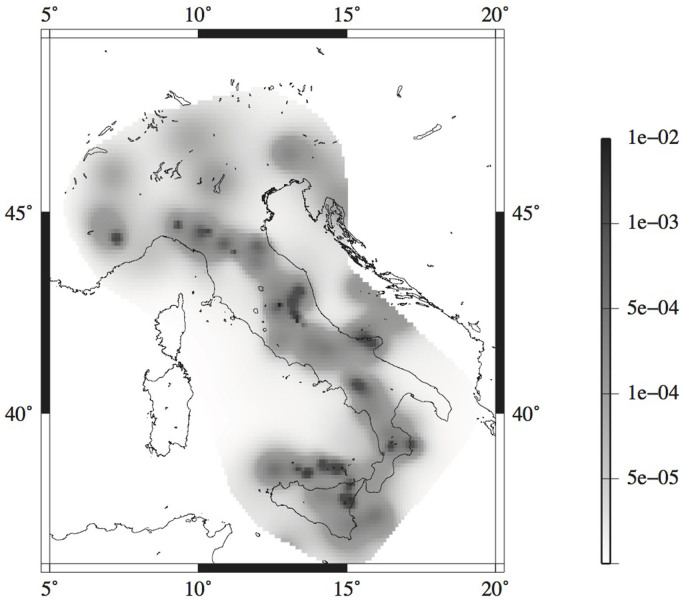
Background spatial probabilities ui (see eq. 9) adopted for ETAS simulations. The map was created using the software Generic Mapping Tools (http://gmt.soest.hawaii.edu/).